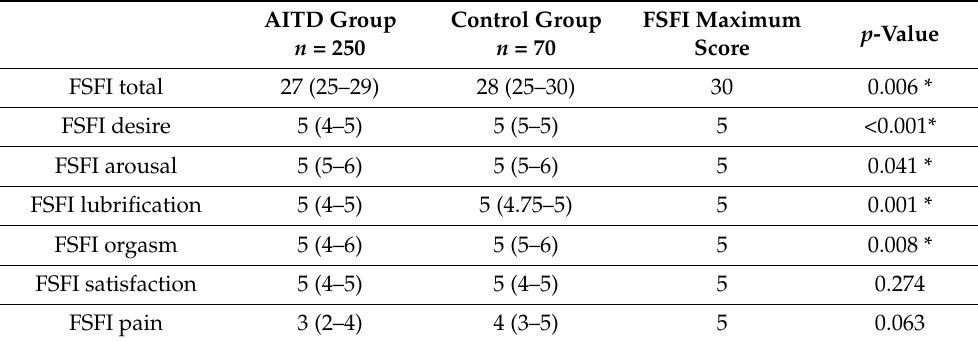
Table 3. Comparison between AITD group and healthy patients in terms of FSFI